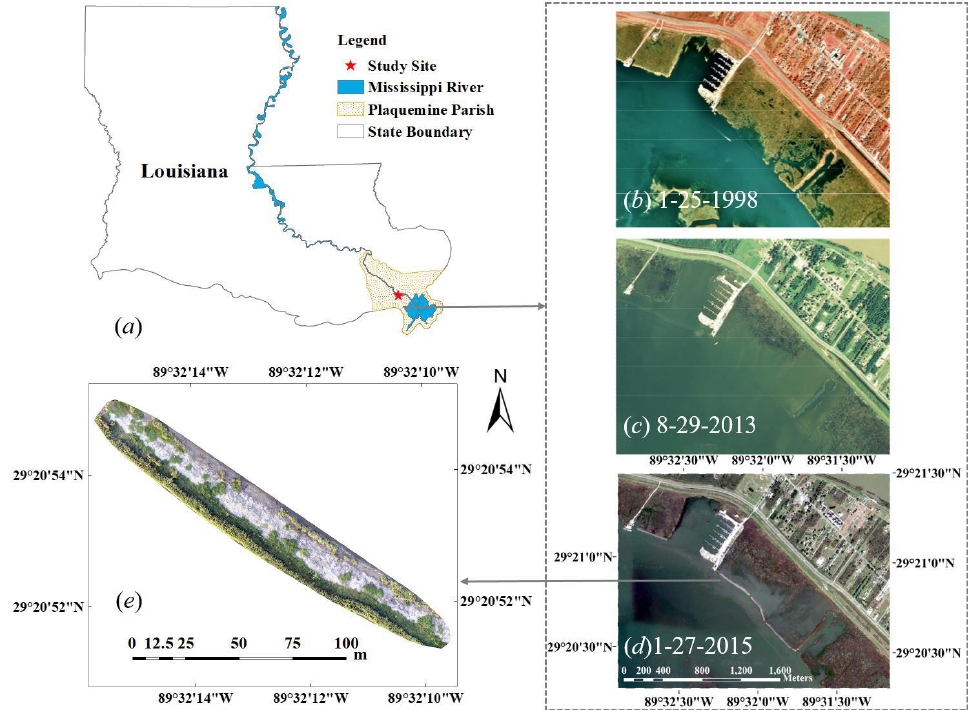
Figure 1. ( a ) Study site at the Buras Boat Harbor, Plaquemines Parish, Louisiana. The images in ( b ) and ( c ) are aerial photographs from the USGS website and demonstrate the wetland degradation phenomena from 1998 to 2013. The 2015 Google Earth image ( d ) shows the landscape after sand berm reconstruction. Image ( e ) is the orthophoto from UAV data collected on 1 October